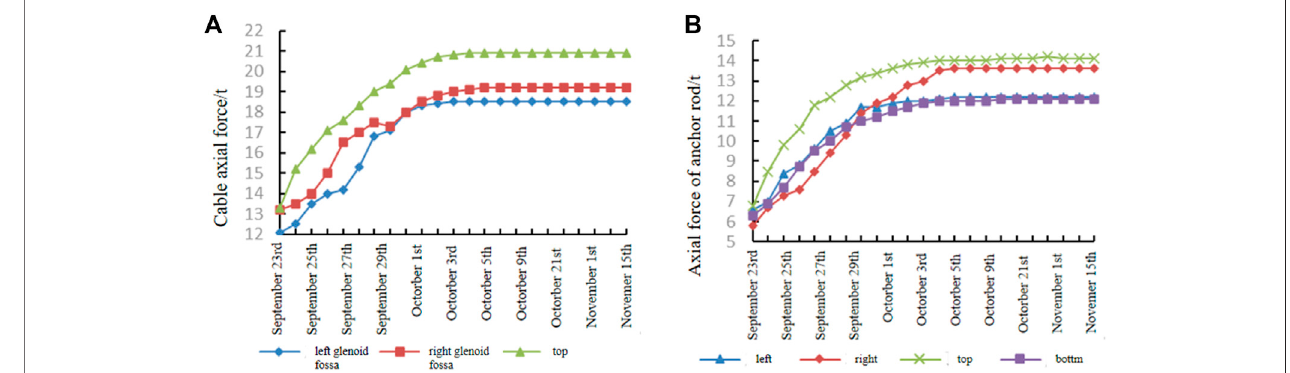
FIGURE 8 | Anchor – anchor cable stress monitoring chart. (A) Anchor, (B) Anchor cable.